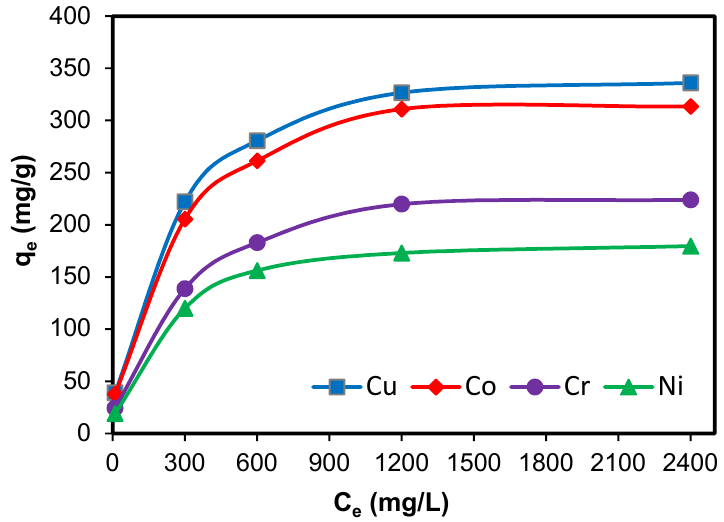
Figure 12. The effect of different initial heavy metals concentrations on adsorption by poly(hydroxamic acid) ligand; experimental conditions: 100 mg of dried poly(hydroxamic acid), 5 mL of 0.1 M CH 3 COONa buffer solution, and 5 mL of 0.1 M heavy metal solutions (10, 300, 600, 1200 and 2400 ppm) at pH 6 agitated for 2 h.